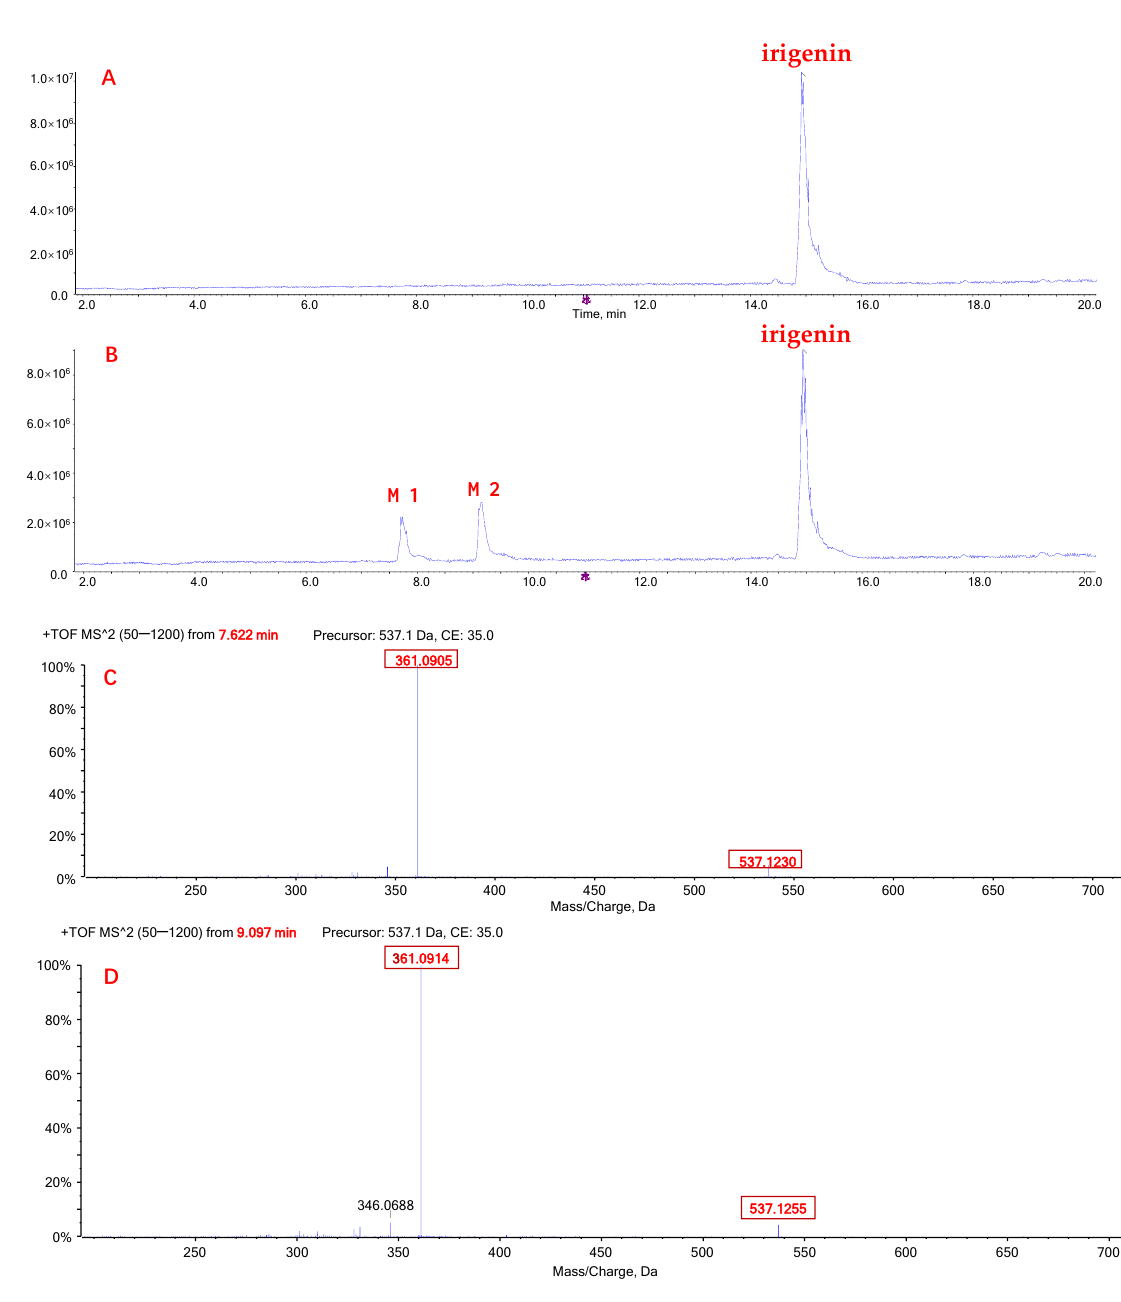
Figure 3. Representative chromatograms of irigenin and its glucuronide metabolites M1 and M2. Total ion chromatogram (TIC) after incubation of tectorigenin for 0 h ( A ) and 0.5 h ( B ) at 37 °C; mass spectrometric fragmentation characteristics of glucuronide metabolite M1 ( C ) and M2 ( D ) of tectorigenin.